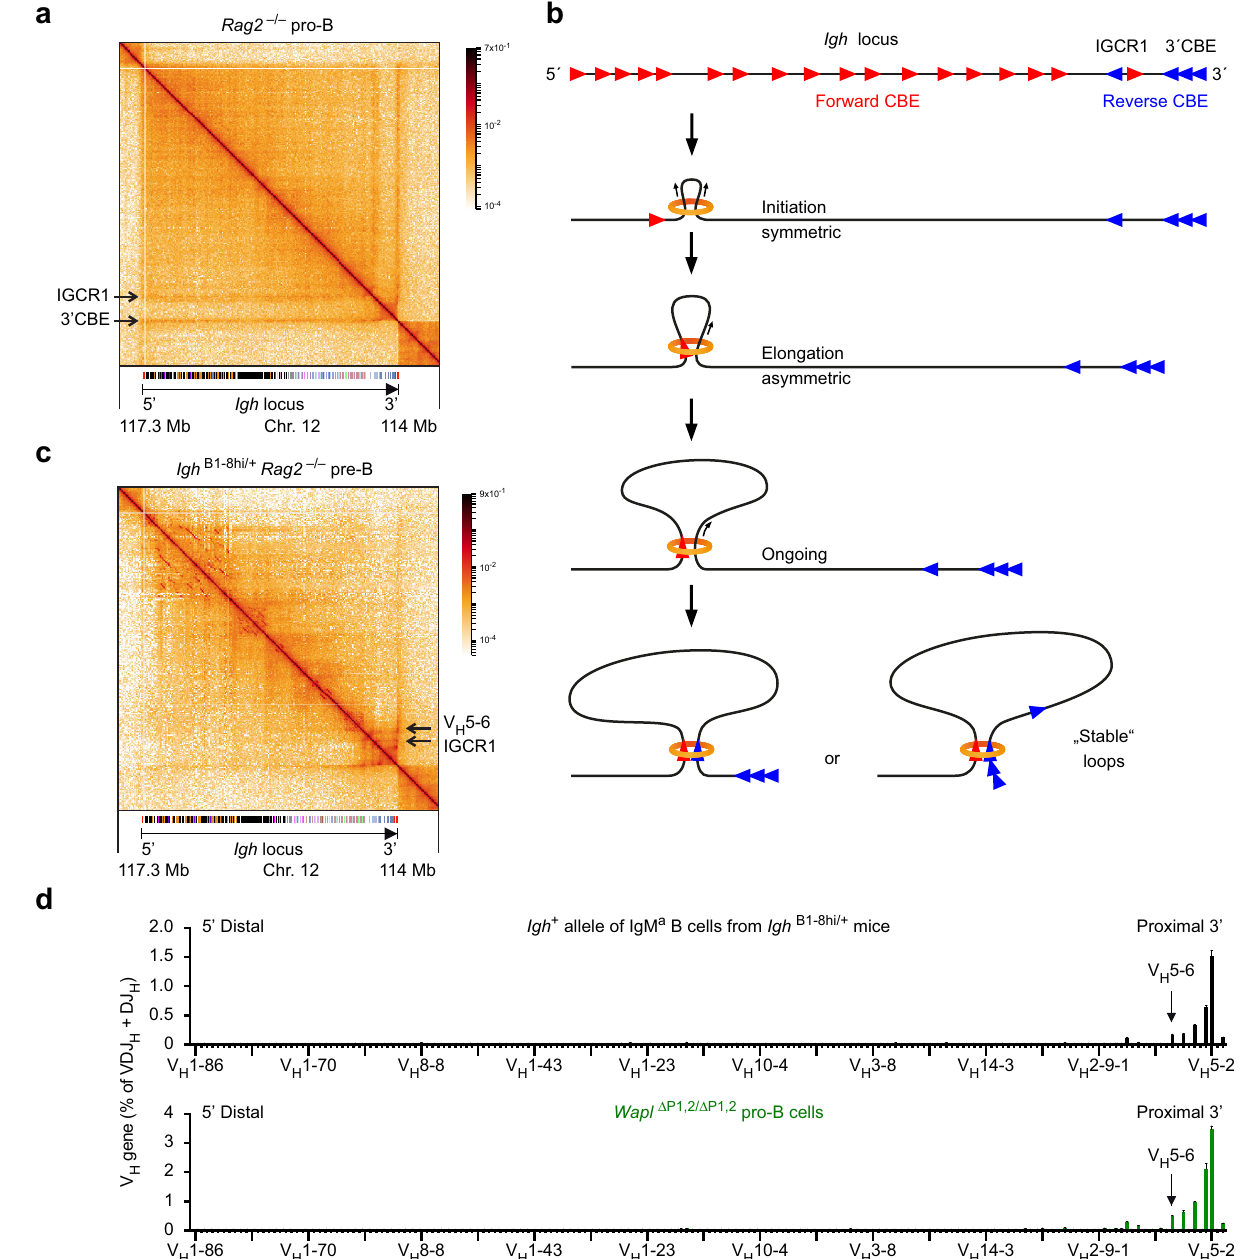
Fig.6|HighdensityofinteractionsacrosstheV H geneclusterinpro-Bcellsand decontraction of the Igh locus in pre-B cells. a Contact matrix of the Igh region (onchromosome12)inexvivosorted Rag2 – / – pro-Bcells.Theinteractiondatawere generated by Micro-C analysis and are displayed at a 10-kb bin resolution with the HiGlass visualization tool 81 . Each dot on the contact matrix represents the contact intensity between a pair of nucleosomes, as displayed according to the density scale shown. White lines denote regions that could not be mapped due to low contact density. The annotation and orientation of the Igh locus is shown below. The stripes corresponding to interactions from the 3 ’ CBE or IGCR1 region are indicated. b Schematicdiagramexplainingthechromatinloopingatthe Igh locusin pro-B cells. The forward CBEs (red arrowheads) in the V H gene region are shown togetherwiththereverseCBEs(bluearrowheads)attheIGCR1and3 ’ CBEelements. Loop extrusion, upon random initiation in the V H gene cluster, proceeds fi rst in a symmetrical manner, until the cohesin ring (orange) interacts with a CTCF protein bound to the next upstream forward CBE, which leads to stabilized binding of cohesin at this site 48 . Thereafter, asymmetric loop extrusion reels the DNA of the downstream Igh regionsintotheloop,untilitishaltedbyaCTCFproteinboundtoa